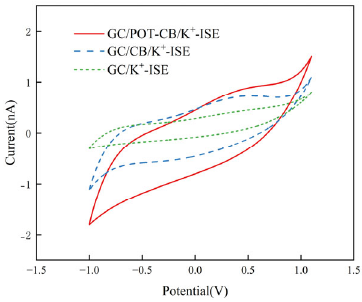
Figure 1. ( a ) Image of CB − ISM solid contact layer, illustration: 1 µm enlarged image; ( b ) image of POT − CB − ISM solid contact layer, illustration: 1 µm enlarged image; ( c ) POT − CB − ISM static contact angle image.